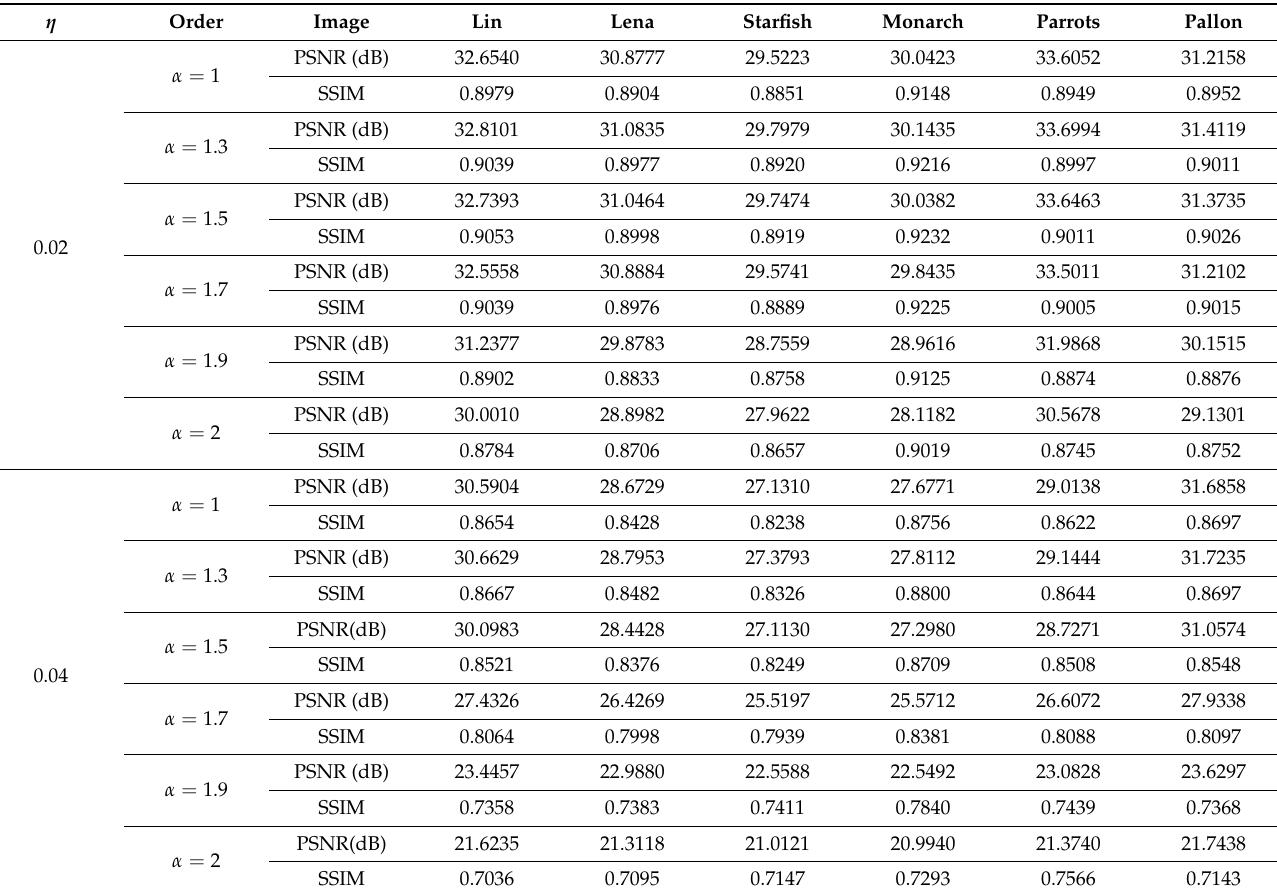
Table 1. The values of PSNR and SSIM by our proposed method with different fractional order parameter α and different noise level.